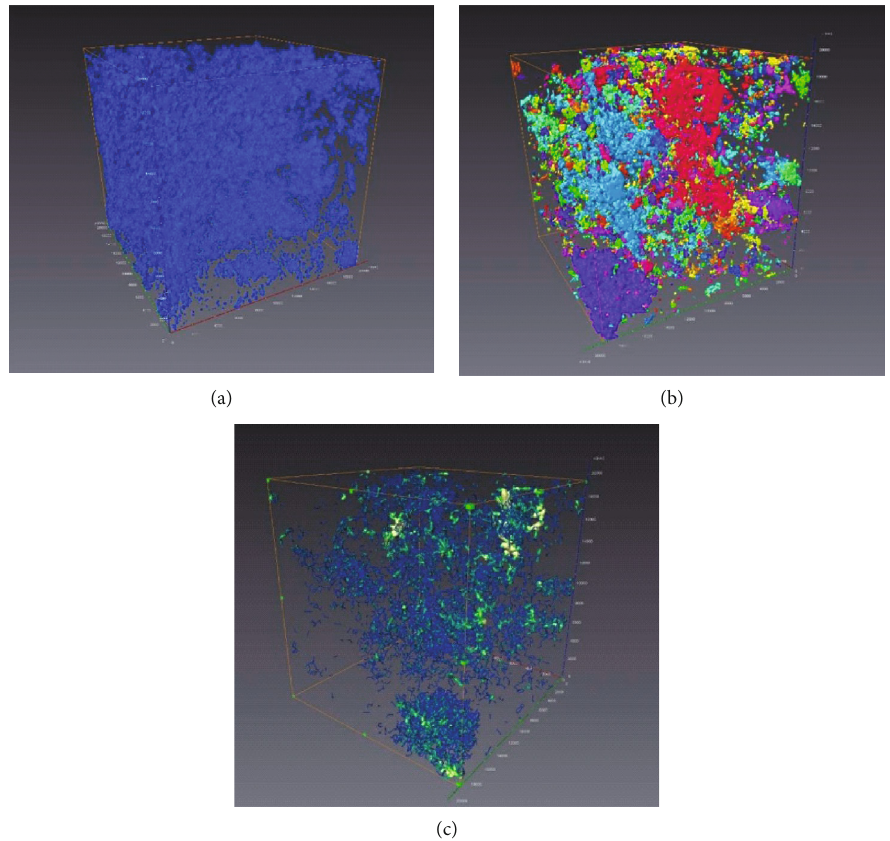
Figure 13: Organic pore characteristics of the organic-material-rich shale based on nano-CT. The TOC is 5.7%. (a) The blue part is organic matter. (b) Interconnected pores in the organic matter. (c) Throat distribution in the organic